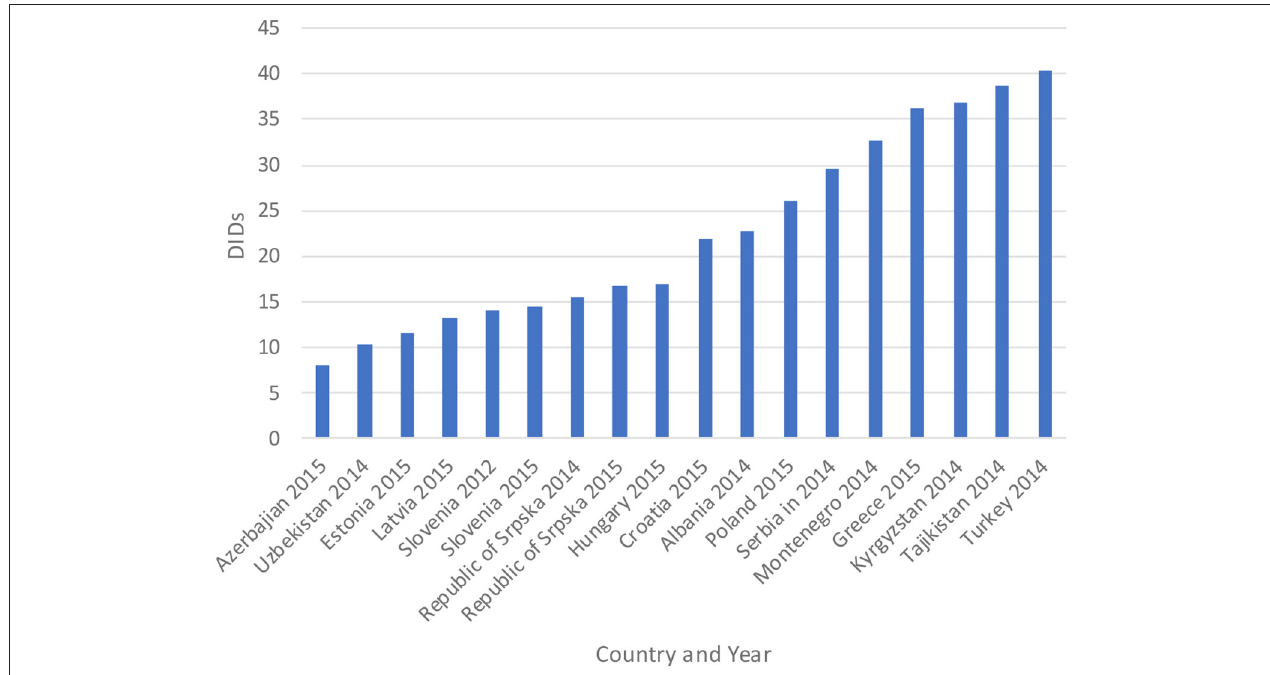
FIGURE 1 | Antibiotic utilization in the Republic of Srpska in 2014 and 2015 (in DIDs) vs. neighboring countries in similar years (Taken from Fürst et al., 2015; WHO EUROPE, 2017; ECDC, 2018).